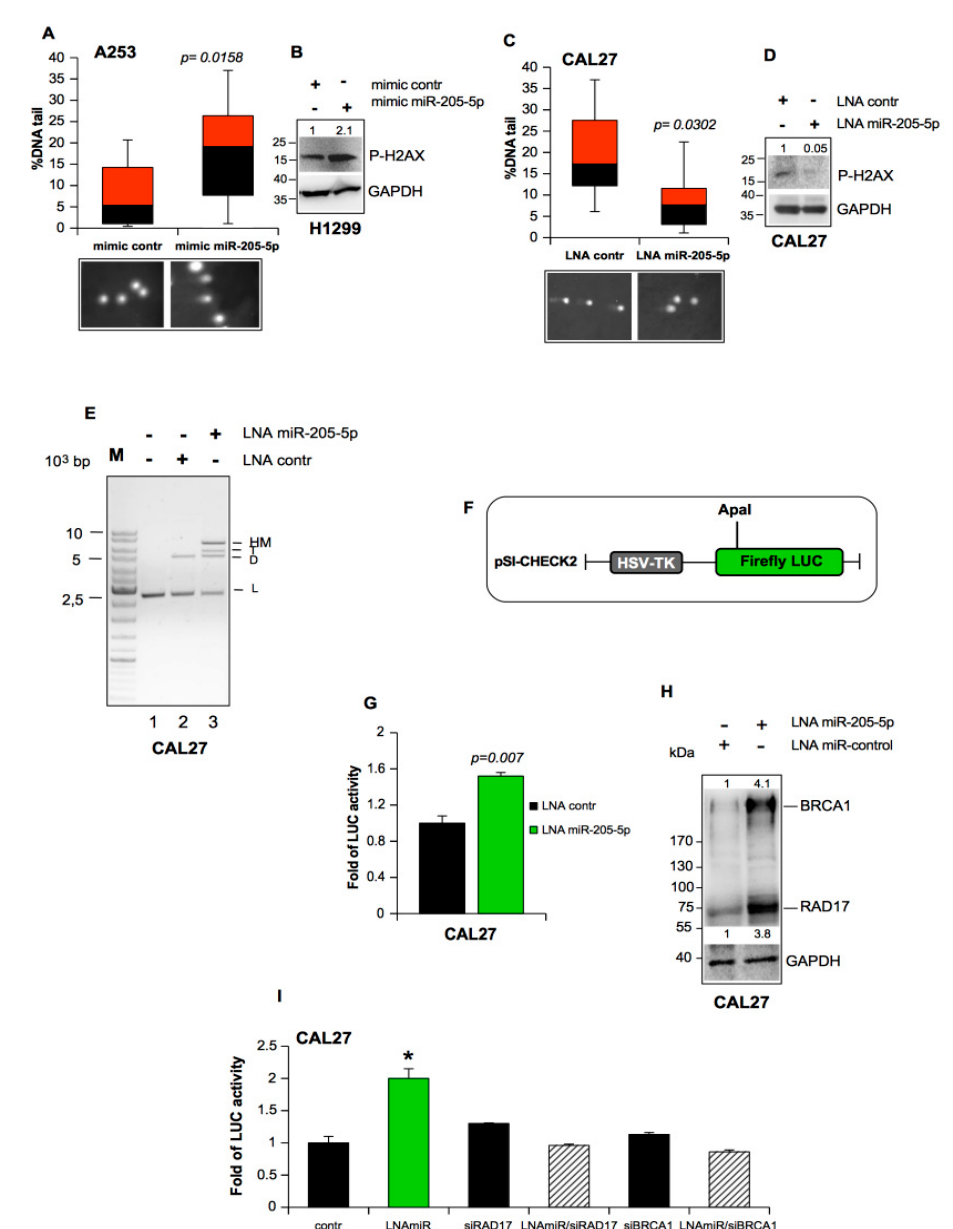
Figure 3. MiR-205-5p expression impairs DNA repair activity. ( A ) H1299 cell lines transfected with mimic control and mimic miR-205-5p were analyzed for the amount of damaged DNA by comet assay using the alkali method. The extent of DNA damage is related to the amount of DNA in the tail. The percentage of DNA in the tail is reported as a box-plot in the higher panels of each figure. About 100 cells were counted for each sample. In all box-plots, the black box is the 25th percentile (first quartile) and the gray box is the 75th percentile (third quartile), while the black band is the median (second quartile). The p -values were calculated with a two-tailed t -test. Statistically significant results had a p -value < 0.05. ( B ) Representative Western blotting of P-H2AX and GAPDH (loading control) protein expression in H1299 cells transfected as described in (A). ( C ) CAL27 cells transfected with LNA control and LNA miR-205-5p were analyzed for the amount of DNA damaged by comet assay using the alkali method. Analysis was performed as described in (A). ( D ) Representative immunoblotting analysis of P-H2AX and GAPDH (loading control) protein expression in CAL27 cells transfected as described in (C). ( E ) DNA repair products after 16 h of incubation at 17 ◦ C with cellular extracts of CAL27 cells transiently transfected with LNA control (lane 2) and LNA miR-205-5p (lane 3) oligos. Lane 1: reaction bu ff er mixture with Hind III-cut plasmid. DNA bands include the following: L, linear DNA; D, dimer; T, trimer; HM, high multimer. Numbers indicate the lanes. M is the DNA ladder. ( F and G ) CAL27